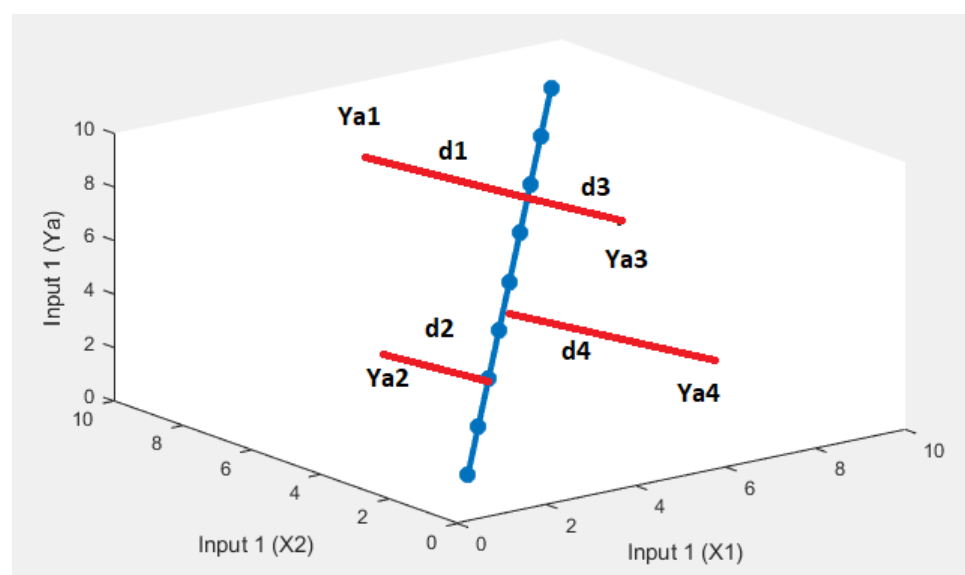
Figure 4. Distance between actual output (Ya) and predicted output (Y) for